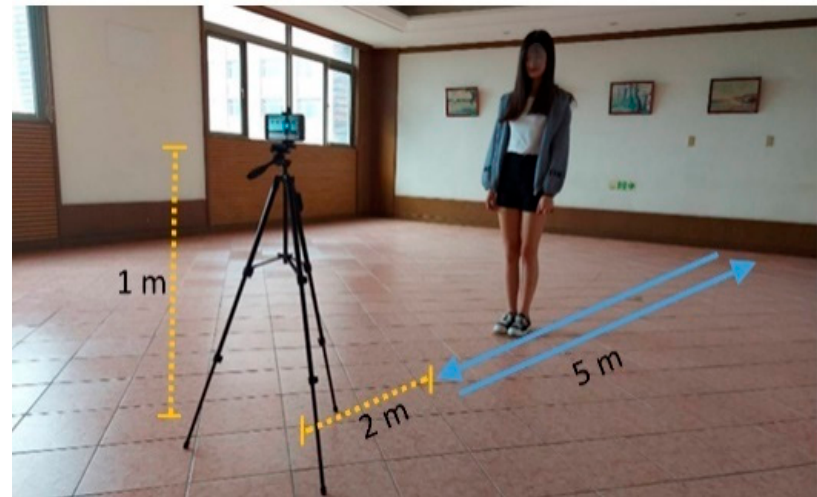
Figure 2. Experimental setup (the cell phone was placed 1 m above the floor and 2 m from the participant).